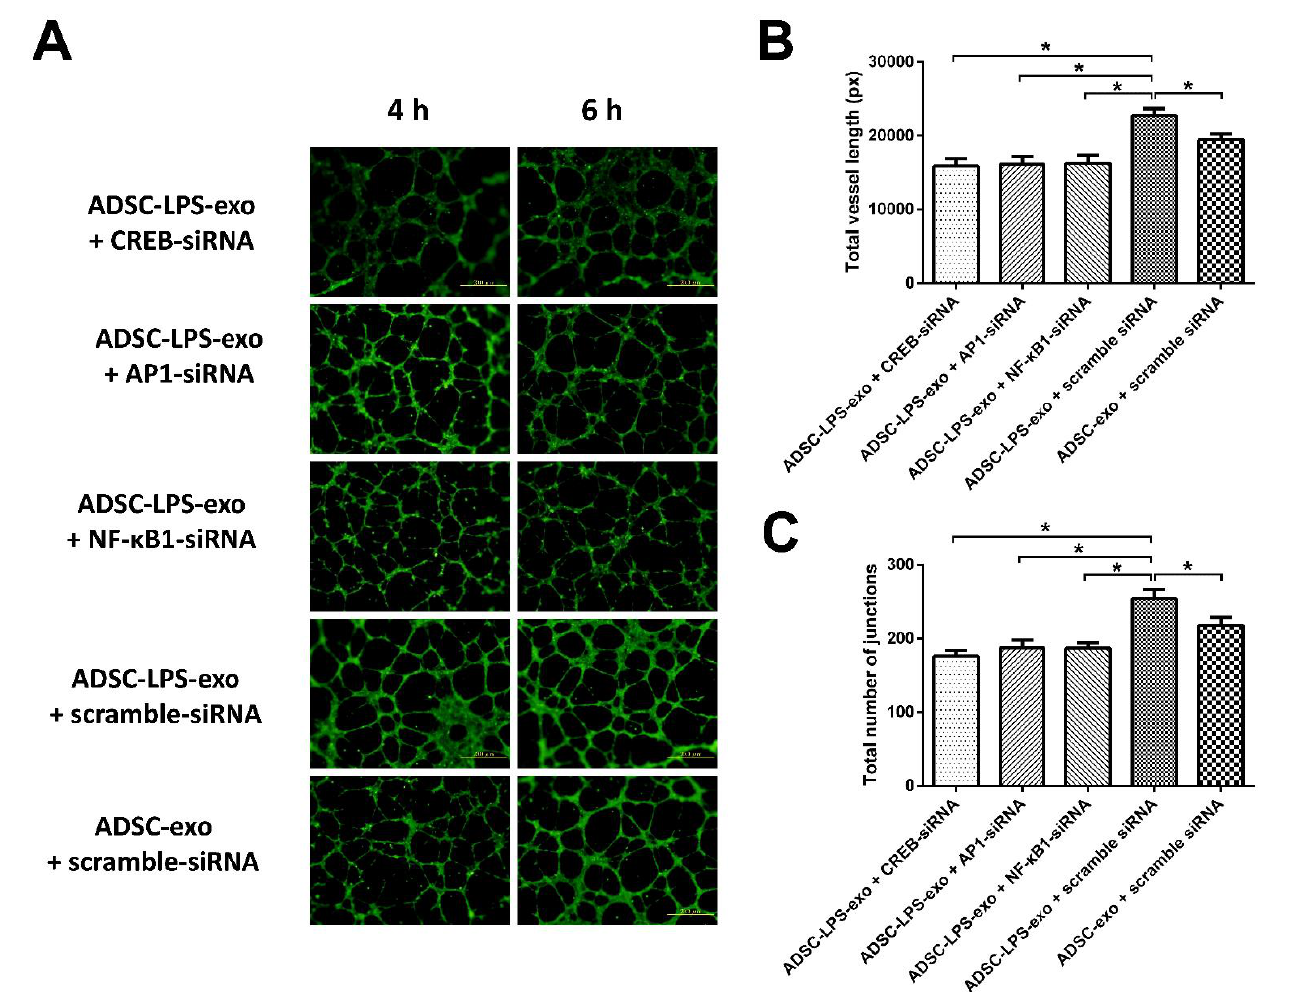
Figure 6. ( A ), After the seeding of FBS-MEM199 at a density of 1 × 10 4 cells/well in 100 µ L culture medium onto a 96-well plate coated with 50 µ L Matrigel per well, tube formation was detected in the HUVECs transfected with 10 nM siRNA-CREB, siR-NA-AP-1, siRNA-NF- κ B1, or scramble siRNAs, followed by ADSC-LPS-exo (30 µ g) treatment as well as in those HUVECs transfected with scramble siRNA and treated with ADSC-exo (30 µ g). ( B ), The bar plots indicate the total vessel length measured by Angiotool at 6 h following exosome treatment. ( C ), The bar plots indicate the total number of junctions measured by Angiotool at 6 h following exosome treatment. n = 6 for each condition. (*, a p -value < 0.05 with at least a 2-fold difference).